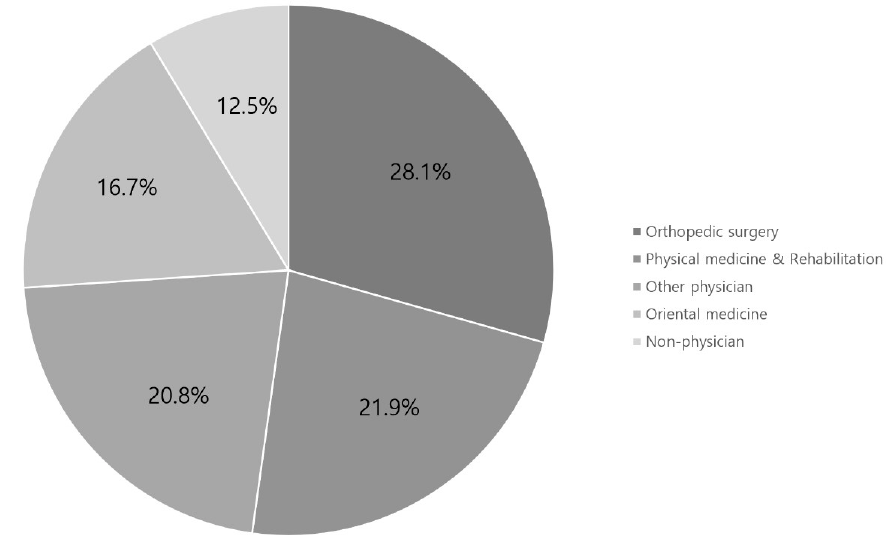
Figure 3. Summary of websites by specialty.